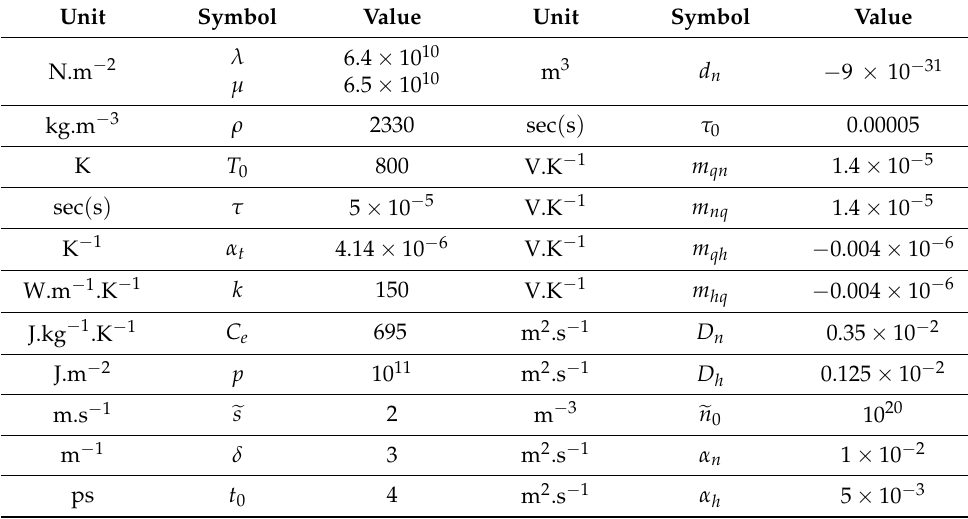
Table 1. The SI units of the physical constants of Si